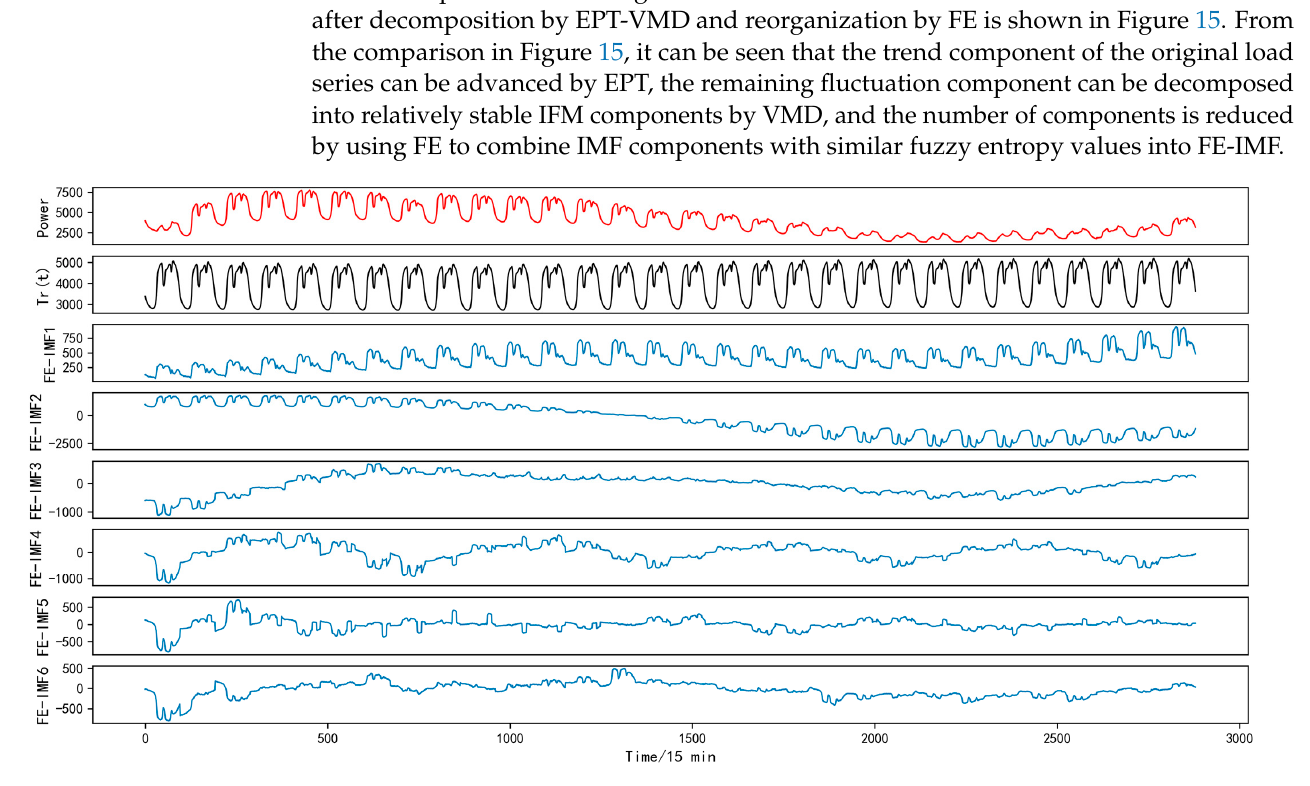
Table 4. FE-IMF composition.